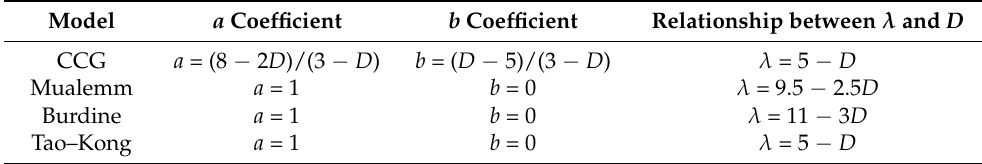
Table 1. The relationship between model coefficients, λ and D .